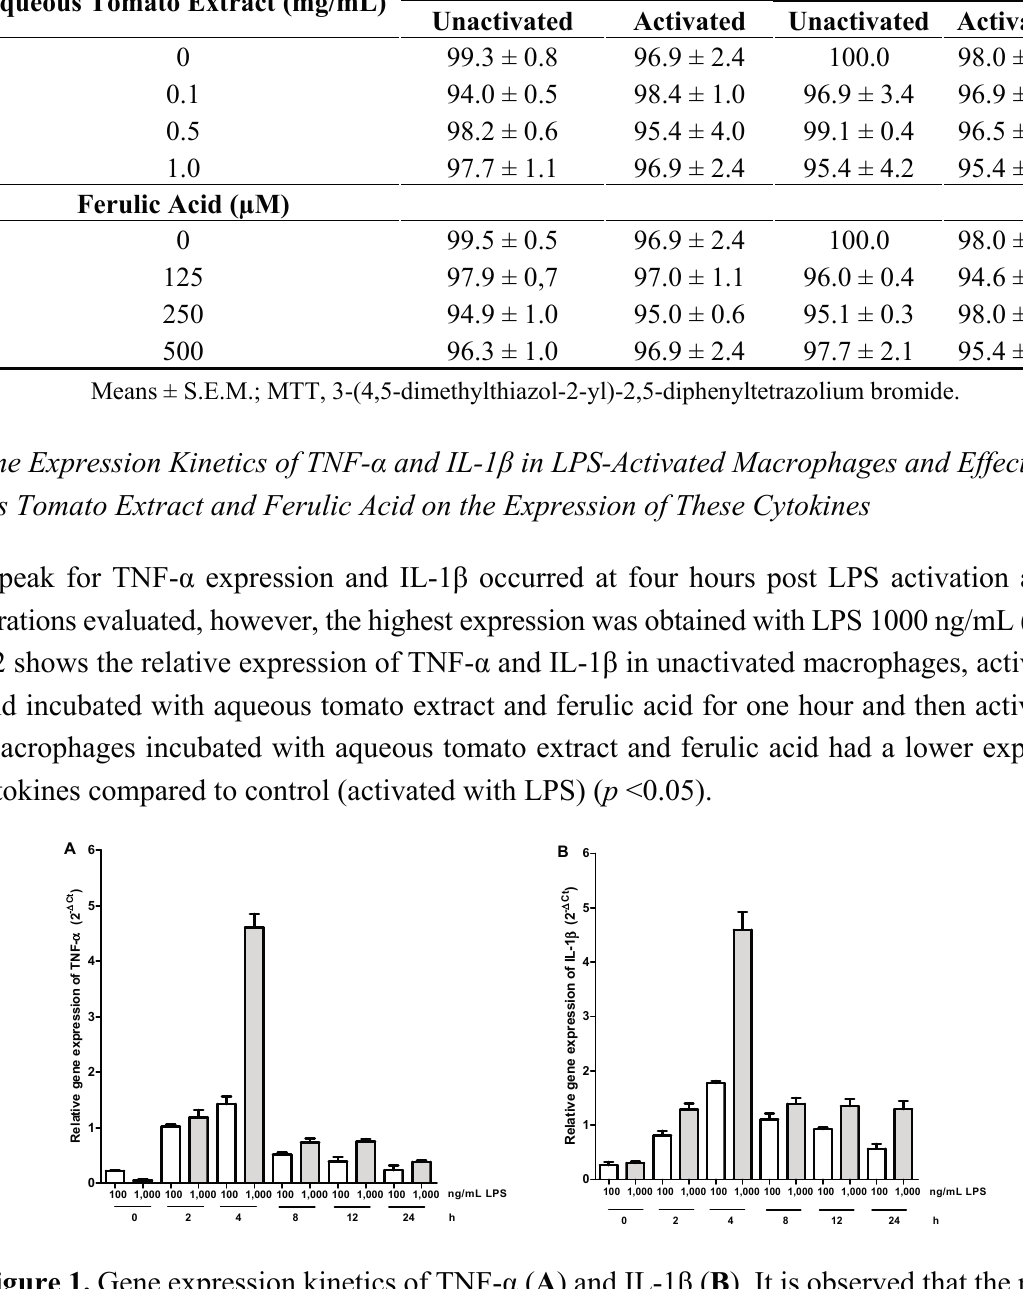
Figure 1. Gene expression kinetics of TNF- α ( A ) and IL-1 β ( B ). It is observed that the peak of expression for both cytokines was 4